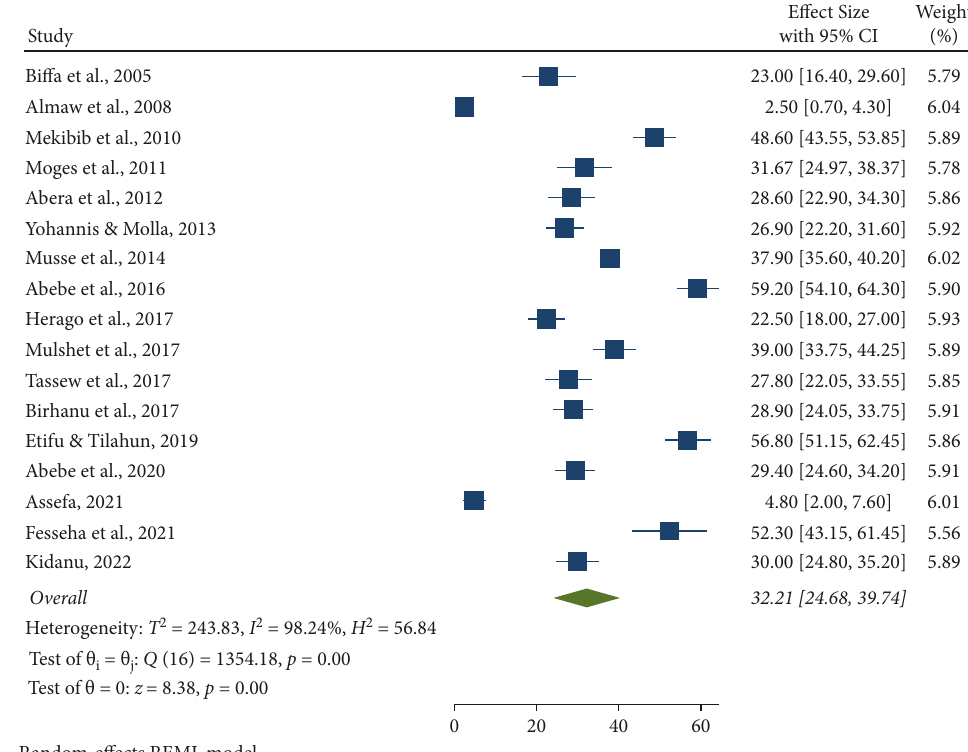
Figure 8: Pooled prevalence of subclinical mastitis among dairy cows from 2005 to